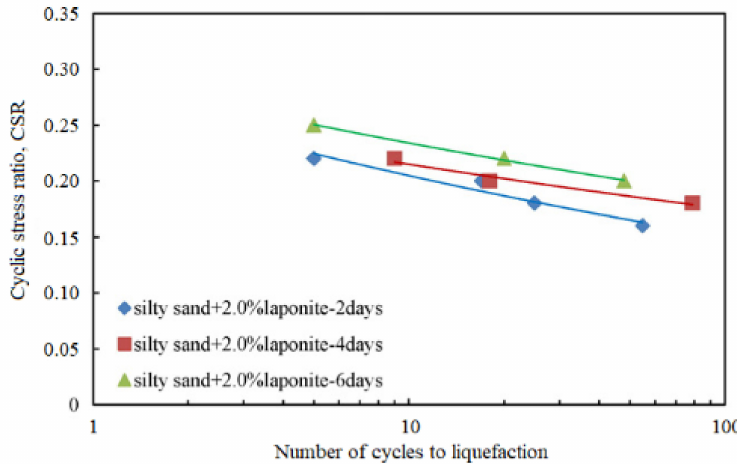
Figure 4. The relationship between CSR and number of cycles to liquefaction for laponite-treated samples with different curing time